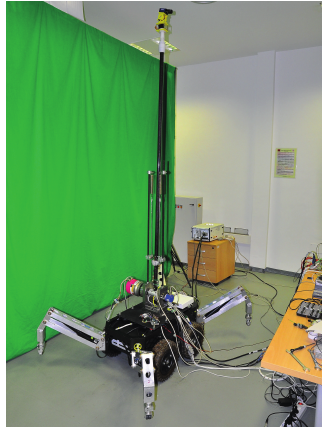
Figure 19. Experimental